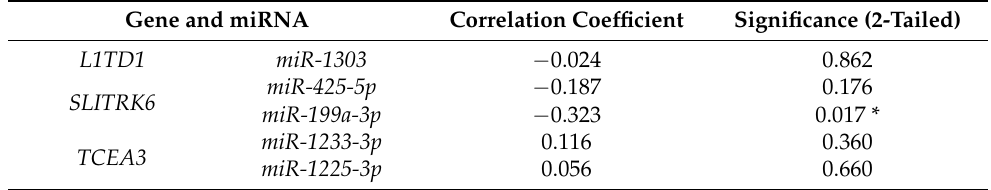
Table 4. Spearman’s correlation coefficients between expression of genes and their potentially regulatory miRNAs.